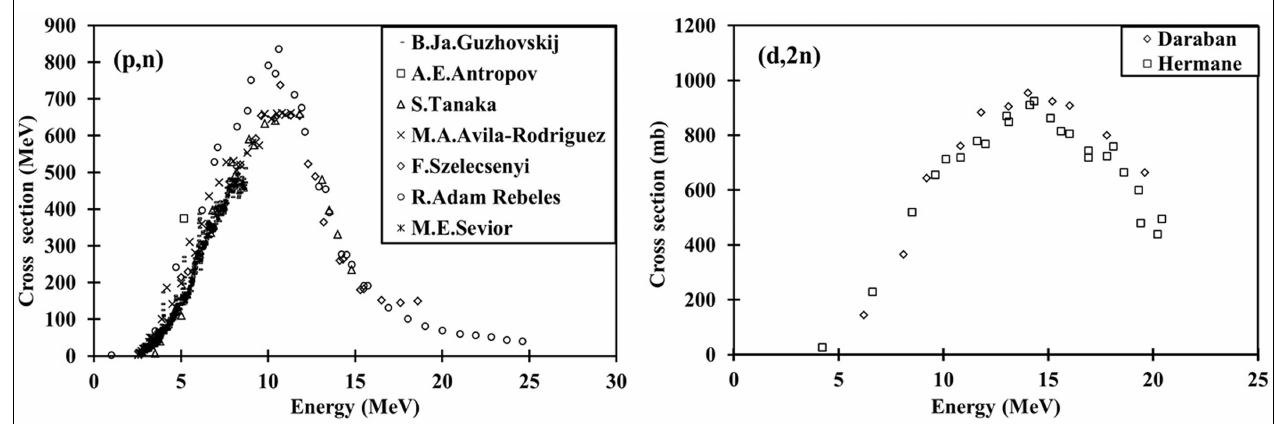
FIGURE 4 | Production cross-section as a function of the projectile energy for Ni-64(p,n)Cu-64 (left) and Ni-64(d,2n)Cu-64 (right) . Inspired by Ref. (17).